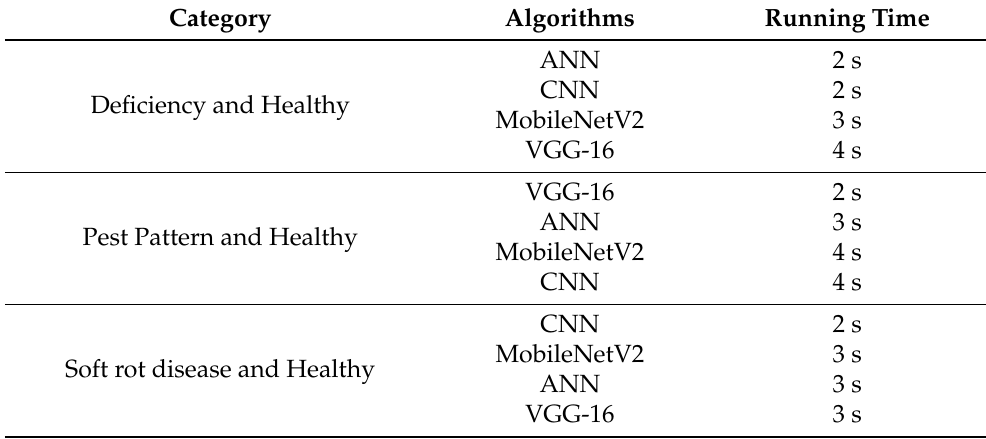
Table 11. Running time of